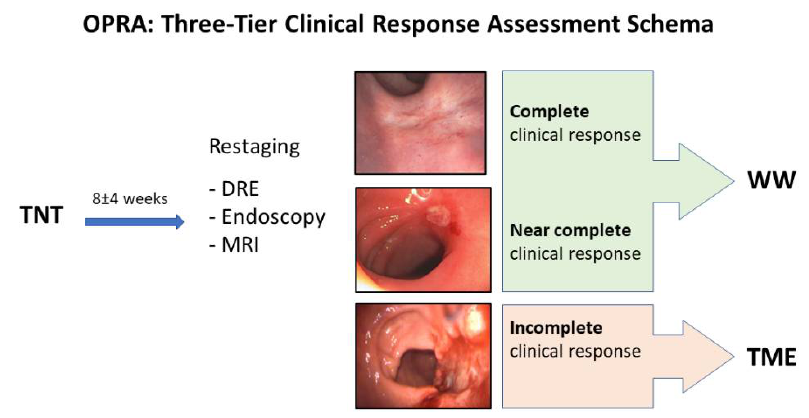
Figure 1. Memorial Sloan Kettering three-tiered response/regression schema.